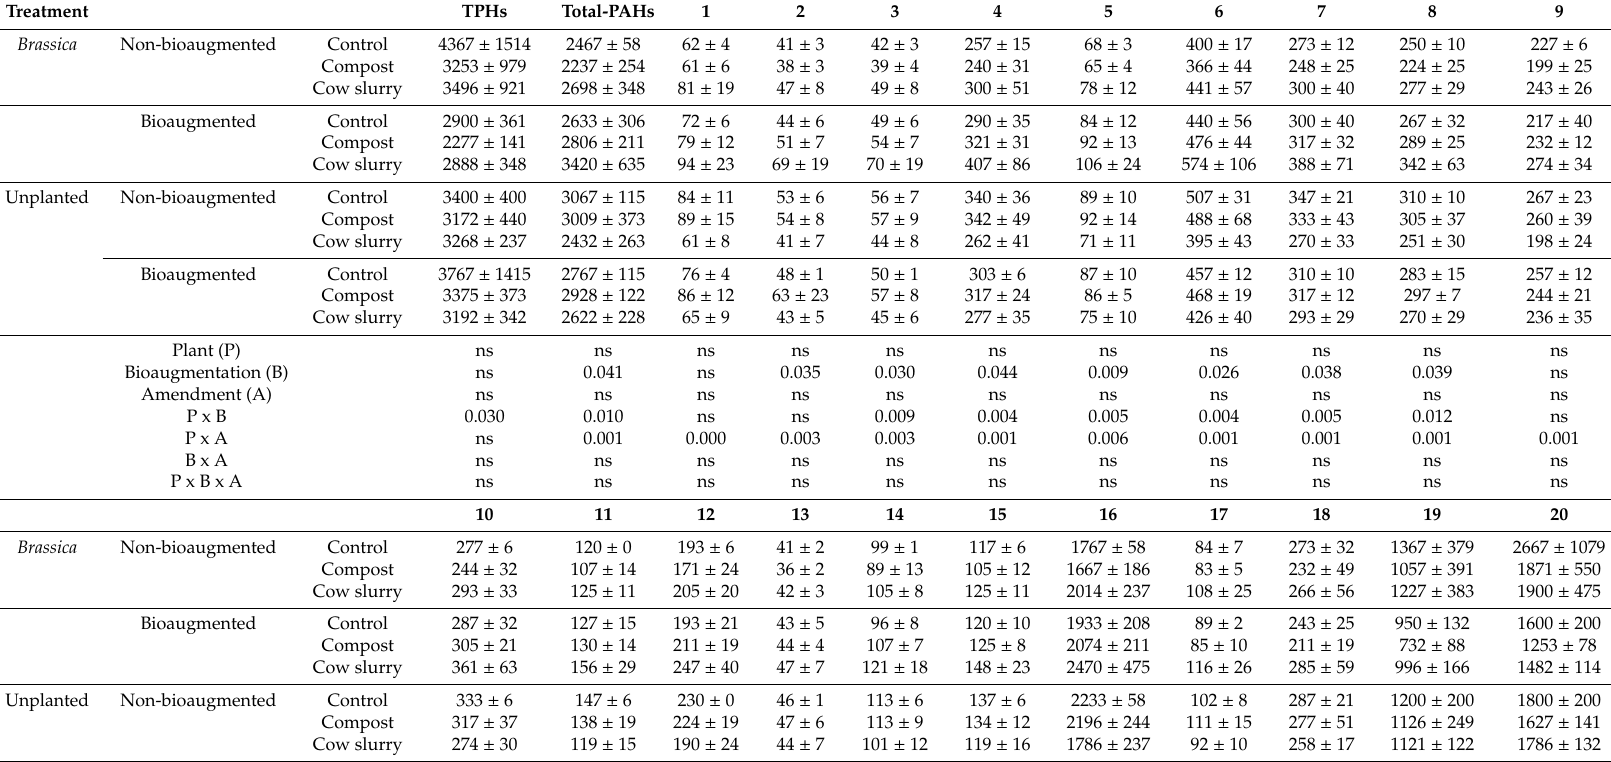
Table 2. Contaminant concentrations. Units: mg kg − 1 DW soil. 1: naphthalene; 2: acenaphthene; 3: fluorene; 4: phenanthrene; 5: anthracene; 6: fluoranthene; 7: